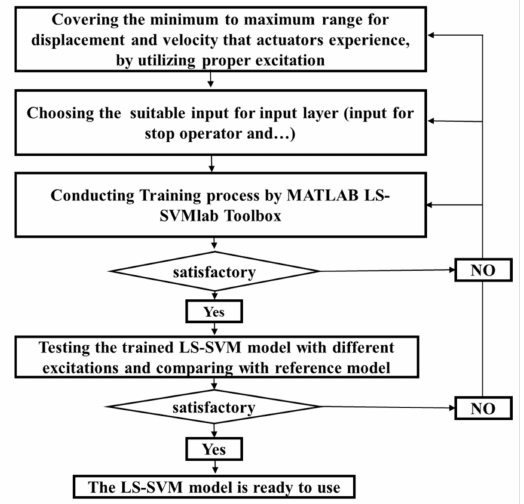
Figure 3. Procedure of training and testing of the LS-SVM hysteresis model.